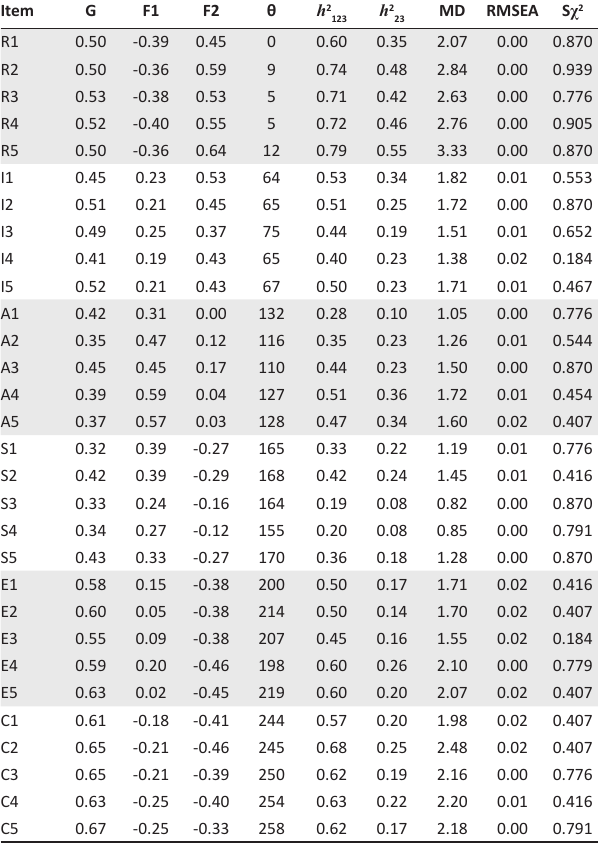
TABLE 3: Target-rotated full information item factor analysis of the 30 SACII-Short